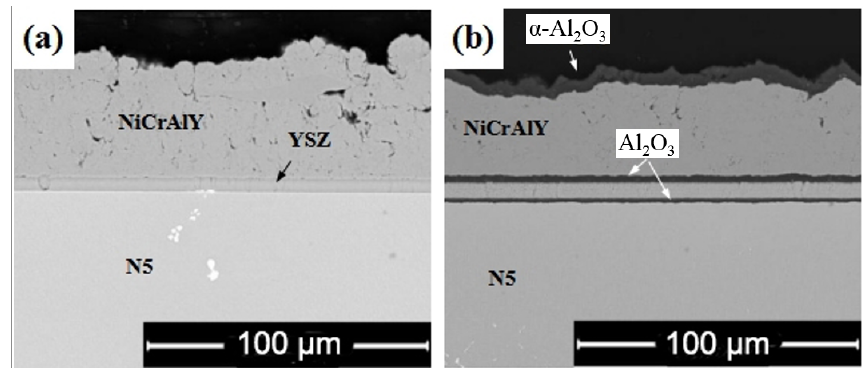
Fig. 46 Microstructure change in the NiCrAlY/YSZ coating system on N5 SX before and after 1000 h oxidation test at 1000 ℃ (YSZ is deposited by EB-PVD): (a) before oxidation and (b) after oxidation. Reproduced with permission from Ref [239], © Elsevier Ltd.